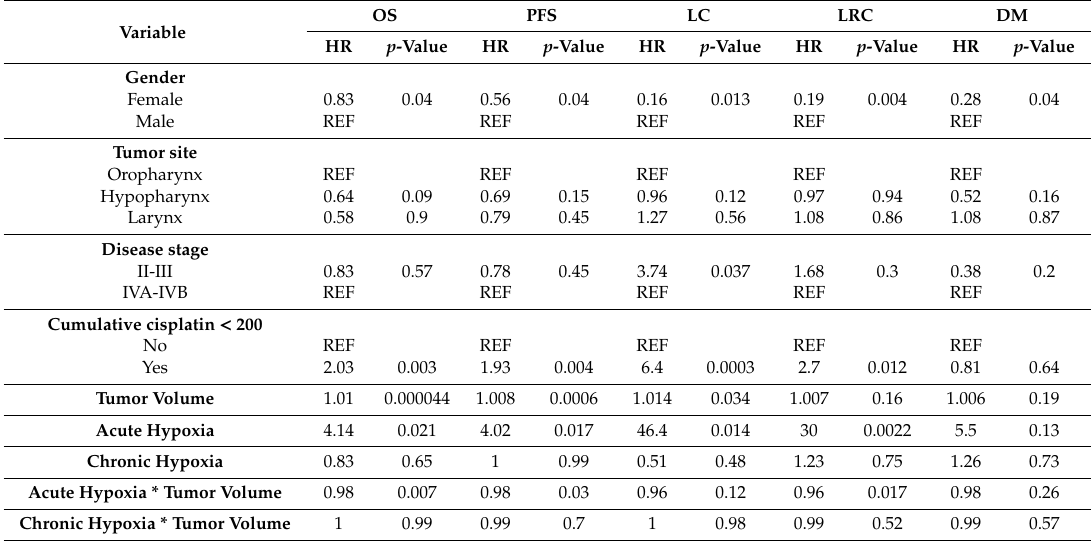
Table 2. Multivariable Cox proportional hazard analysis of parameters with patient outcome in the Van der Heijden